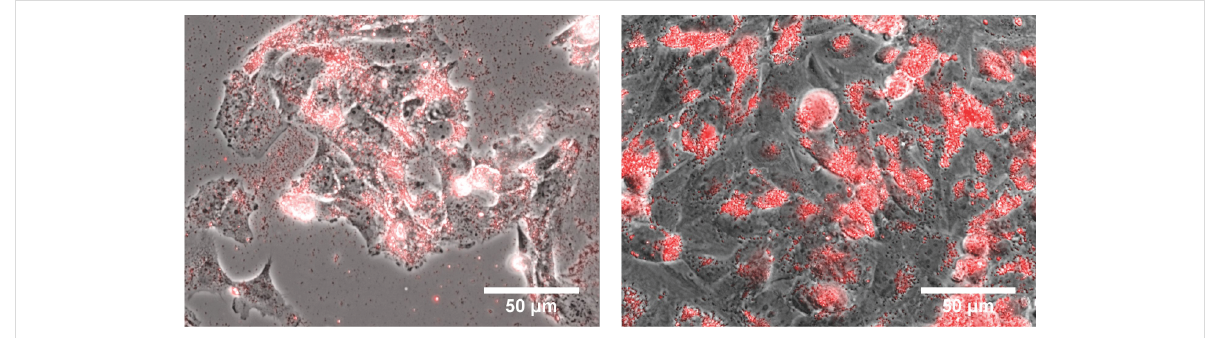
Figure 5: Phase contrast images of photoluminescent NDs (AR-40, 100 µg/mL) incubated with SAOS-2 cells after 3 days (left) and after 7 days